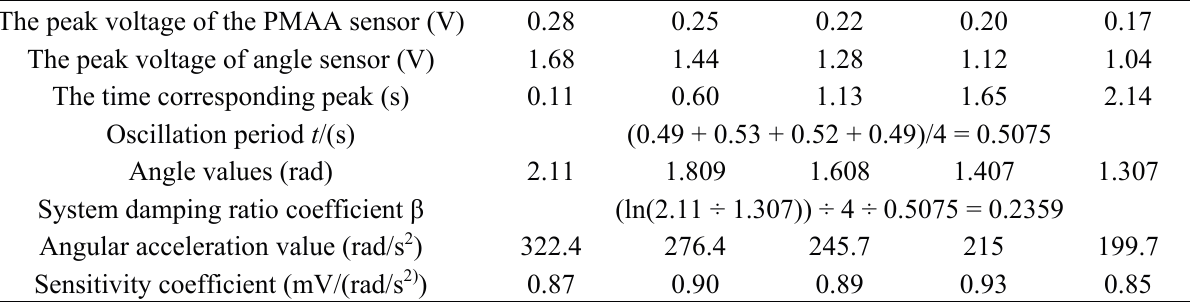
Figure 17. Output voltage of the angle sensor. Table 2. Experimental calibration